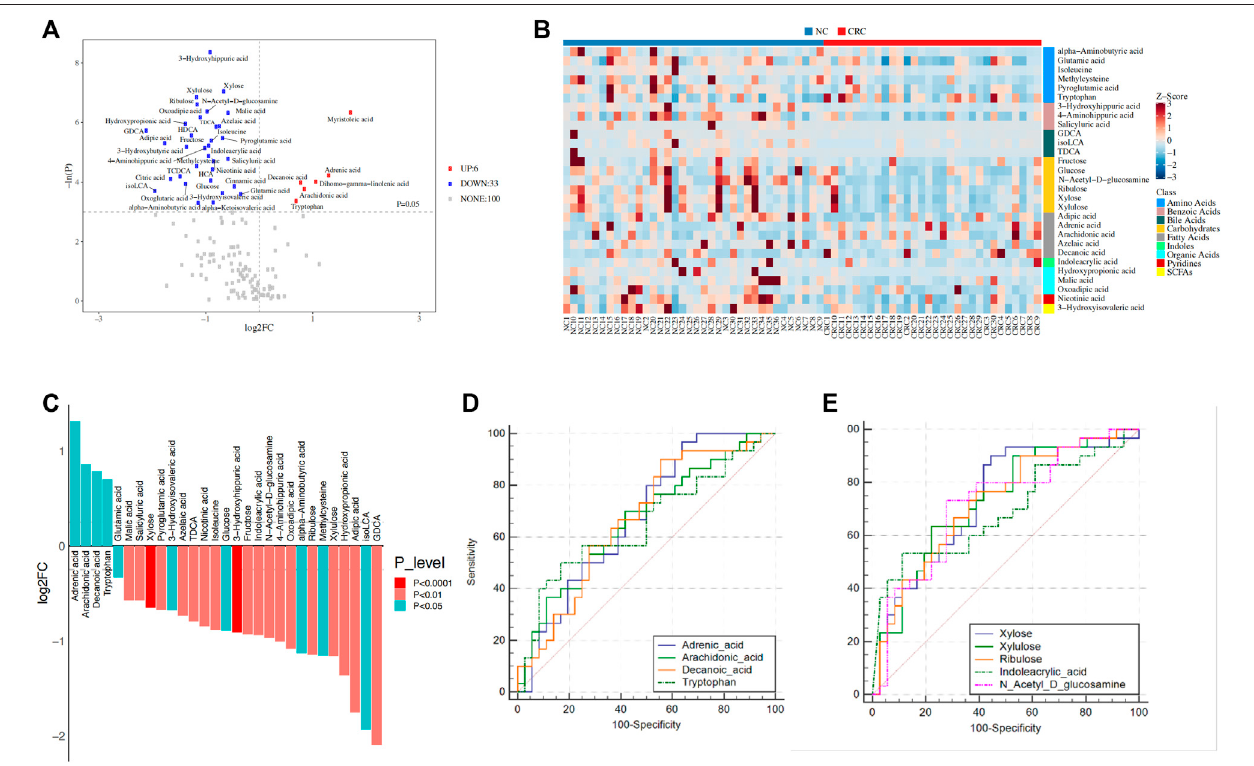
FIGURE 4 | Identi fi cation of metabolites related to CRC. (A) Identi fi cation of dysregulated metabolites in CRC patients and NC controls. p -values were calculated using the Mann – Whitney-Wilcoxon test. (B) Heatmap showing the relative content of dysregulated metabolites. (C) The 29 dysregulated metabolites were selected based on the intersection of univariate analysis and OPLS-DA models. Signi fi cance was determined by the Mann – Whitney-Wilcoxon test. (D,E) ROC curve analysis of upregulated metabolites (D) and the top fi ve downregulated metabolites (E) in the CRC group. OPLS-DA, orthogonal partial least squares discriminant analysis; ROC, receiver operating characteristic; A, colorectal cancer group; B, normal colorectal mucous membrane group.